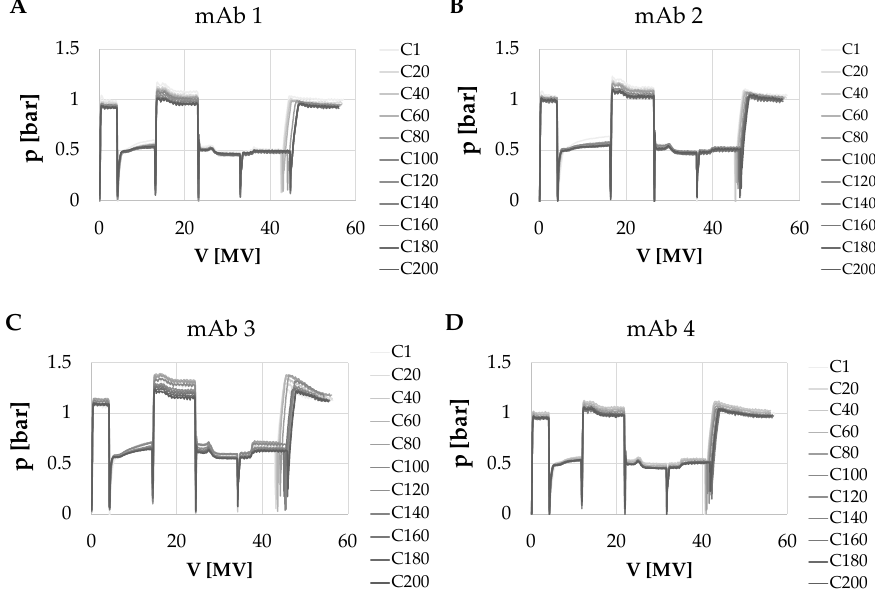
Figure 2. Overlays of pressure traces of 200 bind and elute cycles of mAbs 1–4 ( A – D ). Shown is an overlay of every 20th cycle for each experiment.